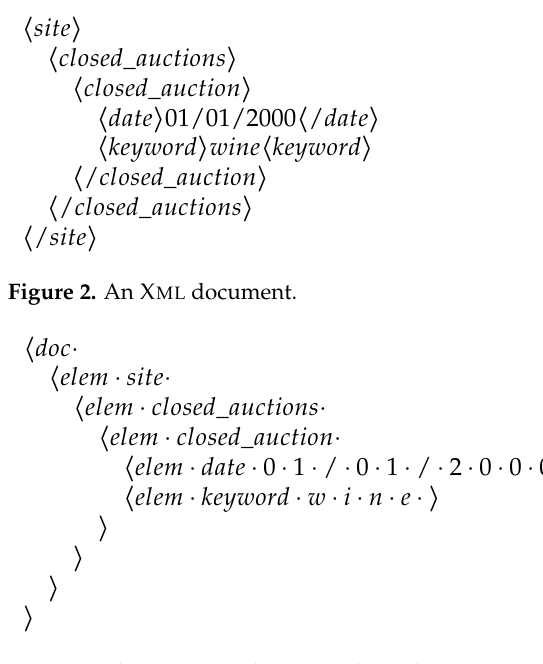
Figure 2. An X ML document.